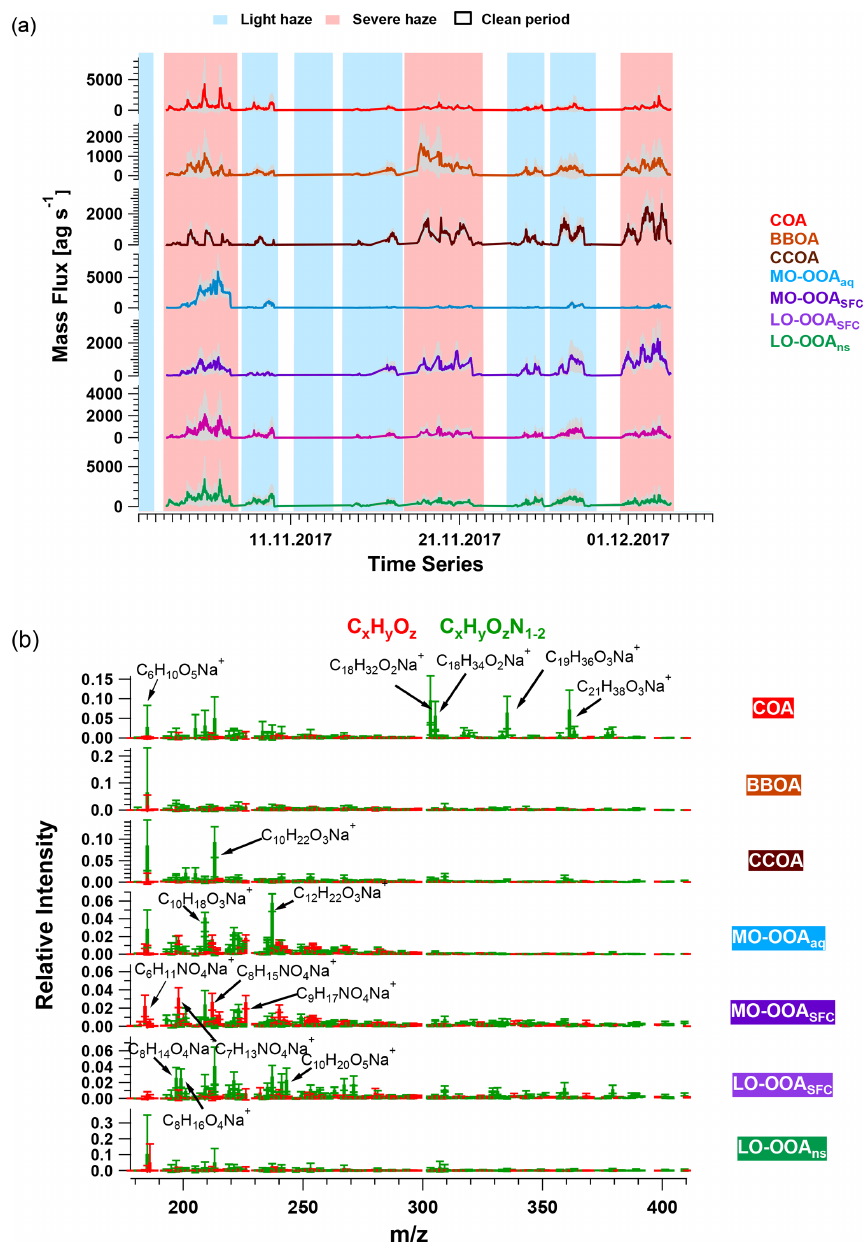
Figure 4. The averaged (a) time series and (b) mass spectra of accepted solutions from combined bootstrap/ a -value analysis of the EESI- TOF dataset. EESI-TOF time series are constrained by the seven non-HOA factors retrieved from AMS PMF analysis. The shaded area in (a) indicates the anchor of bootstrap/ a -value analysis as shown in Eq. (6). Error bars in (b) indicate the standard deviation of each ion calculated from all selected solutions. In (a) , the shaded areas in red and in blue represent severe and light haze periods,